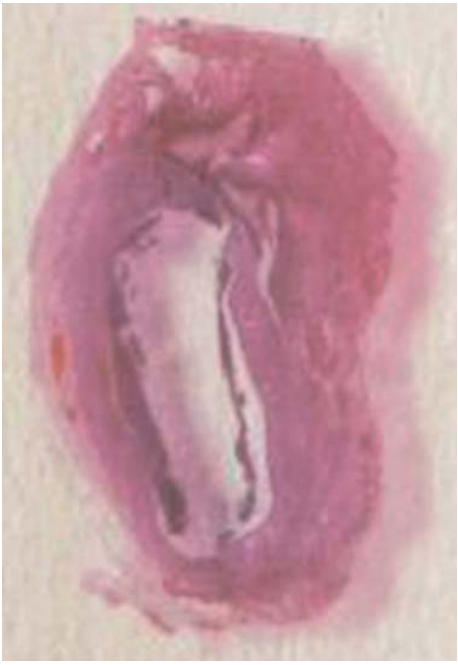
FIGURE 1- Demonstrative image of a histological slice presenting the inclusion criteria established in this